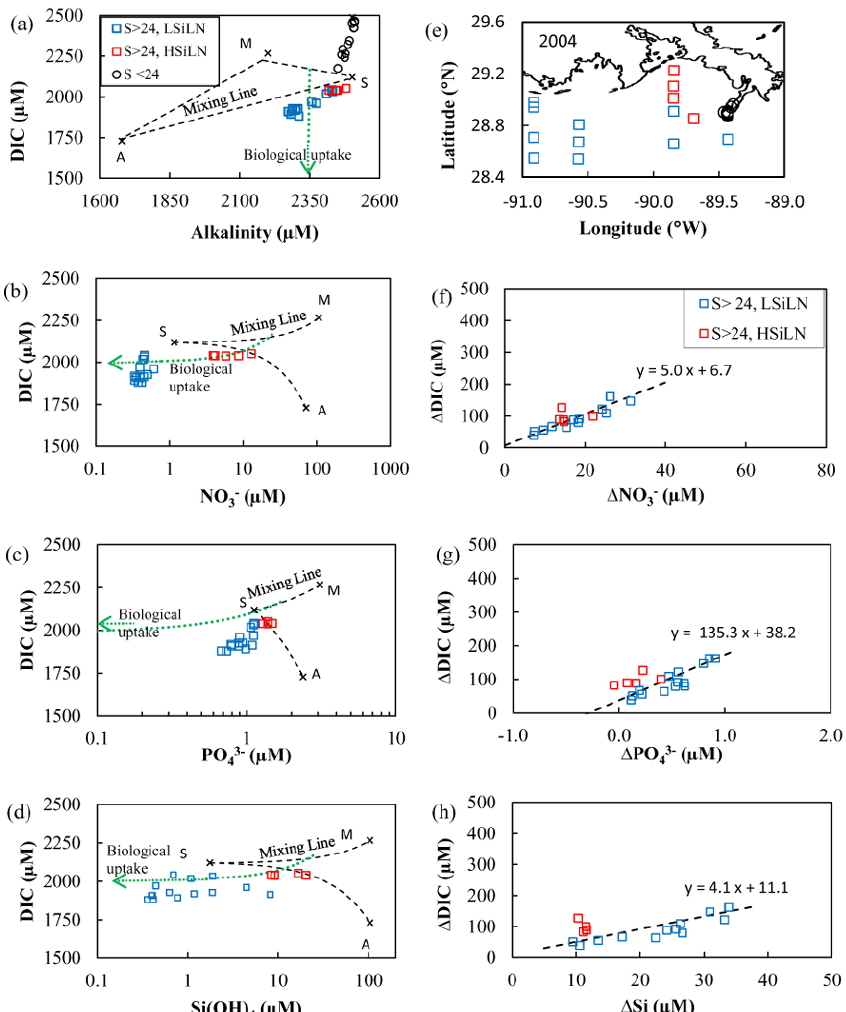
Fig. 5. Relationships between DIC and nutrients, between 1 DIC and 1 nutrients, and their sampling geographic locations for August 2004. Panels (a) to (d) show relationships of DIC and alkalinity, and of DIC and nutrients, with conservative mixing lines (black dashed lines) and Redfield-type biological removal lines (green dashed lines). “ X ” markers with abbreviations “M”, “A”, and “S” are the same end-members as in Fig. 3. For salinity higher than 24, LSiLN data were on the southwestern Louisiana Bight and the adjacent shelf, and for salinity higher than 24, HSiLN data were on the northeastern Louisiana Bight (e) . Salinity less than 24 data were near the Mississippi River mouth. Panels (f) to (h) show relationships of 1 DIC and 1 nutrients with correlation lines (dashed lines). All panels share the same legends as in (a, f) .